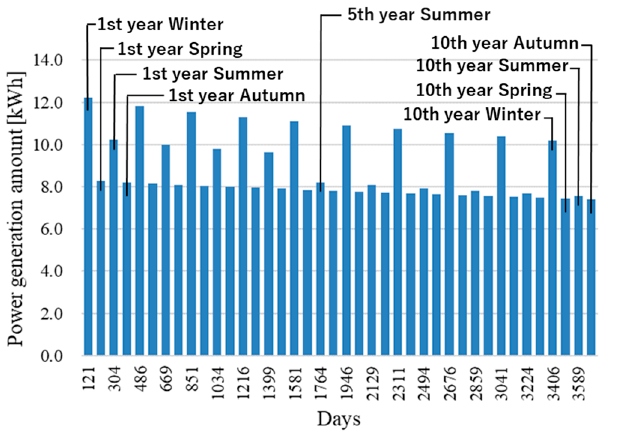
Figure 9. Electrical and heat efficiency transition of the PEMFC-CGS.